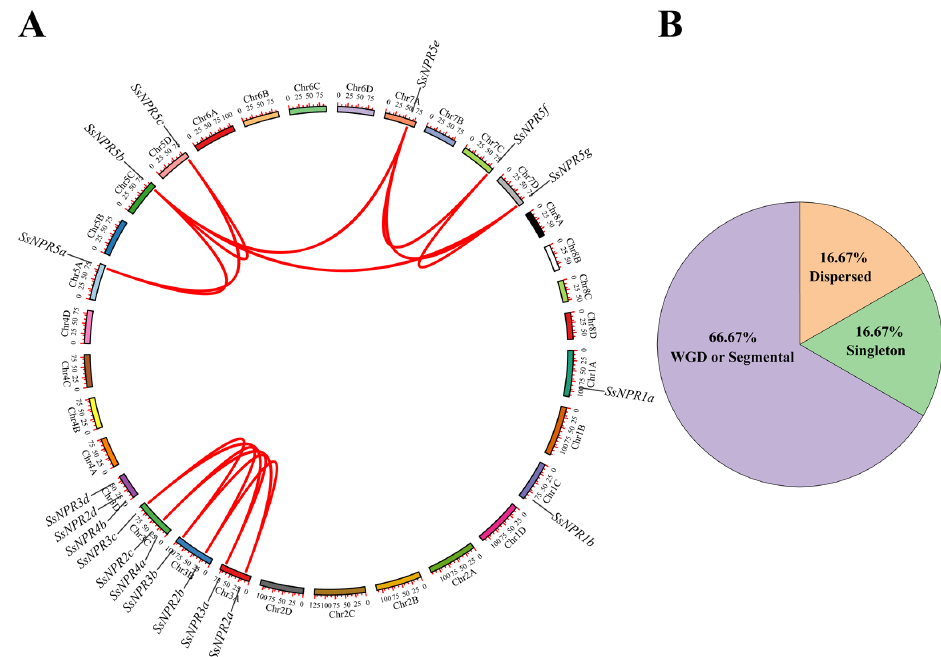
Figure 3. Evolutionary history of NPR1 -like genes in Saccharum spontaneum . ( A ) Synteny analysis of the NPR1 -like genes in S. spontaneum . The red lines represent the SsNPR1 -likes that have been replicated. ( B ) The distribution of gene duplications among SsNPR genes. WGD represents the whole-genome duplication.